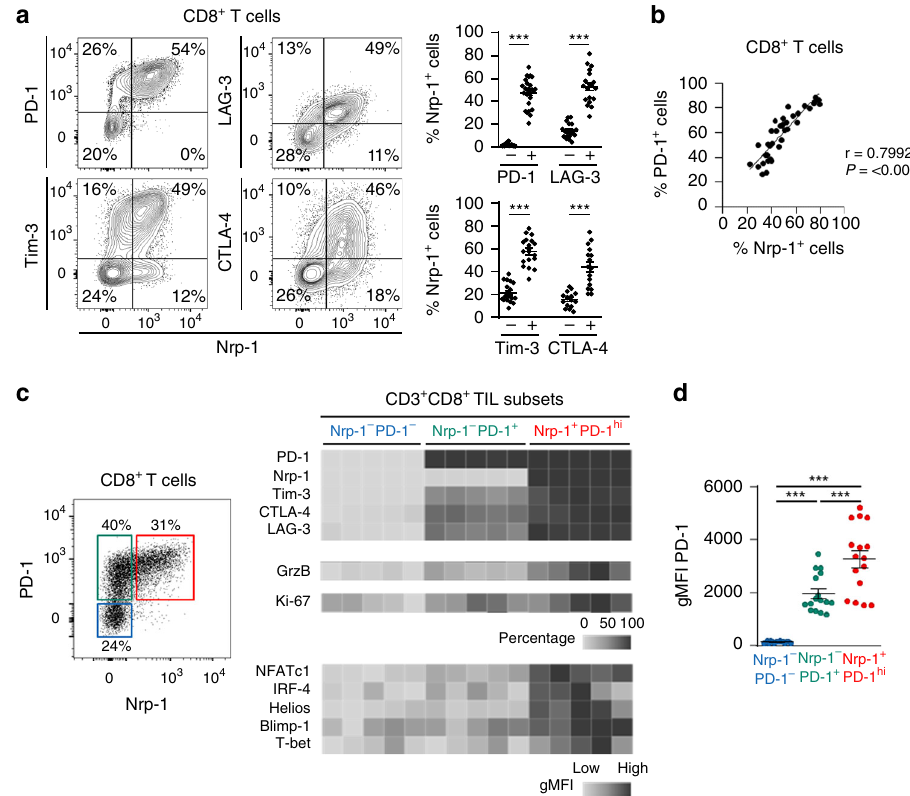
Fig. 4 Expression of T-cell activation/exhaustion markers on the CD8 + TIL. a Expression of Nrp-1, PD-1, LAG-3, CTLA-4 and Tim-3 on CD8 + T cells from B16F10 TIL isolated at day 15. Right: percentages of Nrp-1 among CD8 + T cells expressing or not PD-1 ( n = 26), Tim-3 ( n = 19), LAG-3 ( n = 19) or CTLA-4 ( n = 16). b Expression of Nrp-1 on CD8 + T cells correlated with that of PD-1 ( n = 38). c Expression of Nrp-1 on CD8 + TIL is restricted to a PD-1 hi T-cell population. Left, Expression of Nrp-1 and PD-1 on CD8 + TIL; identi fi cation of three T-cell subsets: Nrp-1 + PD-1 hi , Nrp-1 − PD-1 + and Nrp-1 − PD-1 − . Right: expression of exhaustion/activation markers, functional proteins and transcription factors in Nrp-1 + PD-1 hi , Nrp-1 − PD-1 + and Nrp-1 − PD-1 − CD8 + T-cell subsets. Heat maps including percentages of cells positive for expression of PD-1, Nrp-1, Tim-3, CTLA-4, LAG-3, granzyme B (GrzB) and Ki-67, and gMFI for NFATc1, IRF-4, Helios, Blimp-1 and T-bet ( n = 5). d gMFI of PD-1 on Nrp-1 + PD-1 hi , Nrp-1 − PD-1 + and Nrp-1 − PD-1 − TIL subsets ( n = 16). Results are representative of three to fi ve independent experiments. Means ± SEM two-tailed Student ’ s unpaired t test a or one-way ANOVA test with